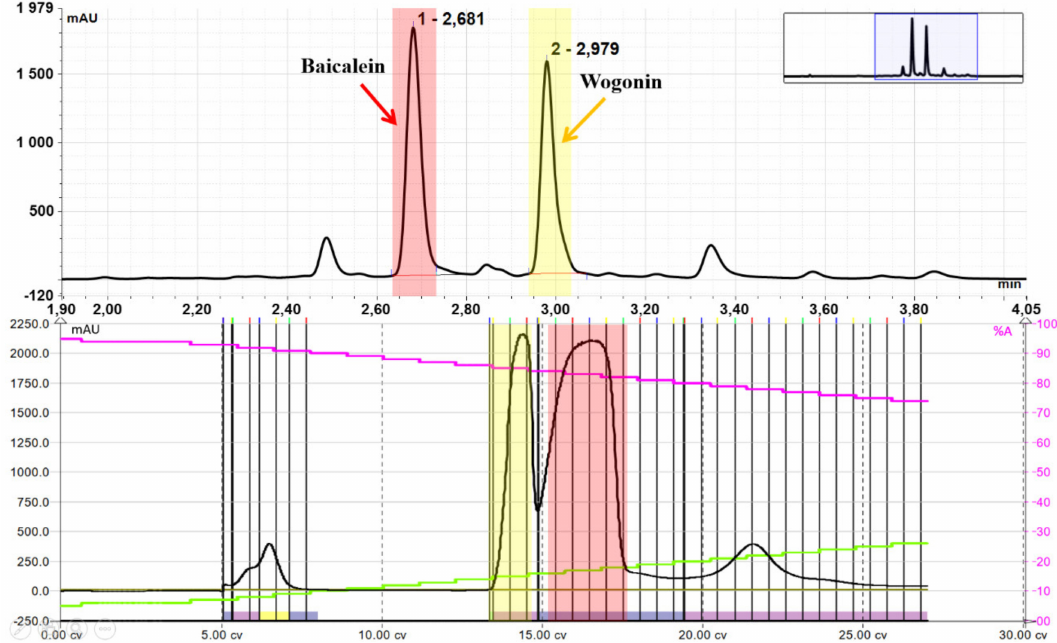
Figure 5. Comparison of UHPLC chromatogram (RP-C18) and FLASH chromatogram (Normal Phase—silica gel 60) of the ethyl acetate extract of hydrolysate of the baikal skullcap